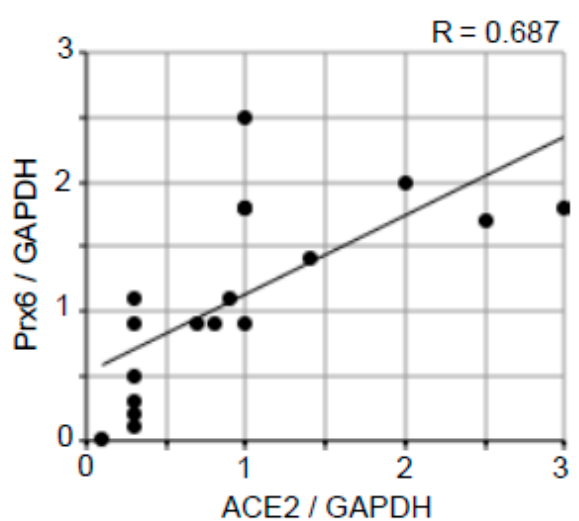
Figure 6. Correlation analysis to examine the relationship between ACE2 protein expression and oxidative stress. The scattered graphs represent ( A ) ACE2 expression vs. protein carbonylation, ( B ) ACE2 expression vs. Prx6 thiol oxidation, and ( C ) ACE2 expression vs. Prx6 expression using Western blotting data (N = 18). Pearson correlation coefficients indicate moderate positive